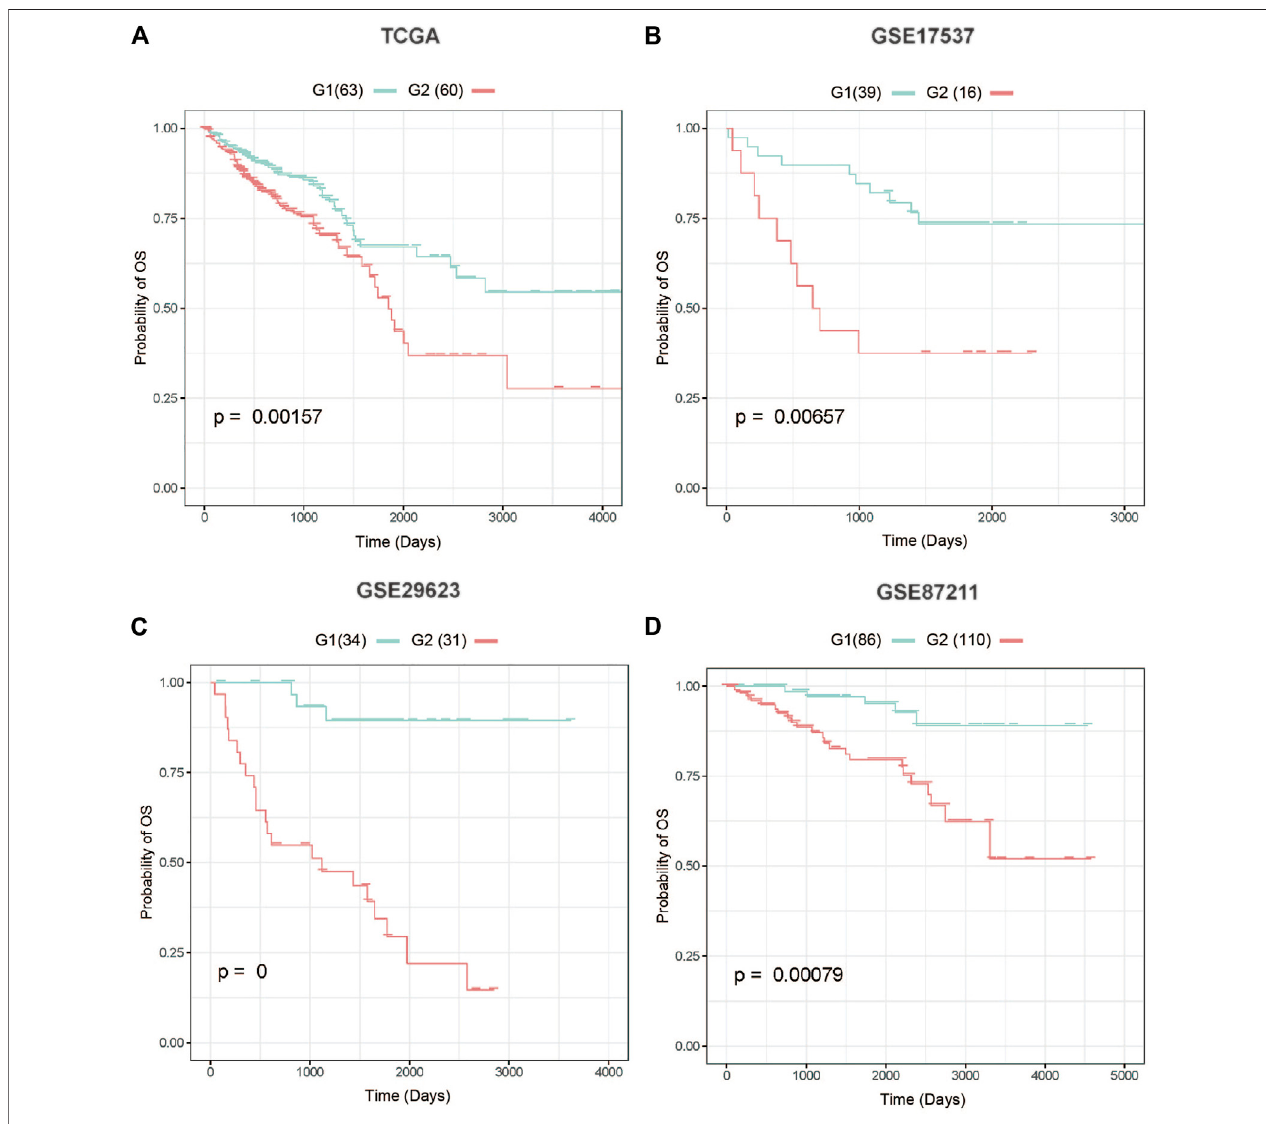
FIGURE 3 | Four test cohorts demonstrating signi fi cant differences in survival rates. (A) The Cancer Genome Atlas (TCGA) test cohort, (B) GSE17537 cohort, (C) GSE29623 cohort, (D) GSE87211 cohort. G2: aggressive (higher-risk survival) subtype; G1: moderate (lower-risk survival) subtype.